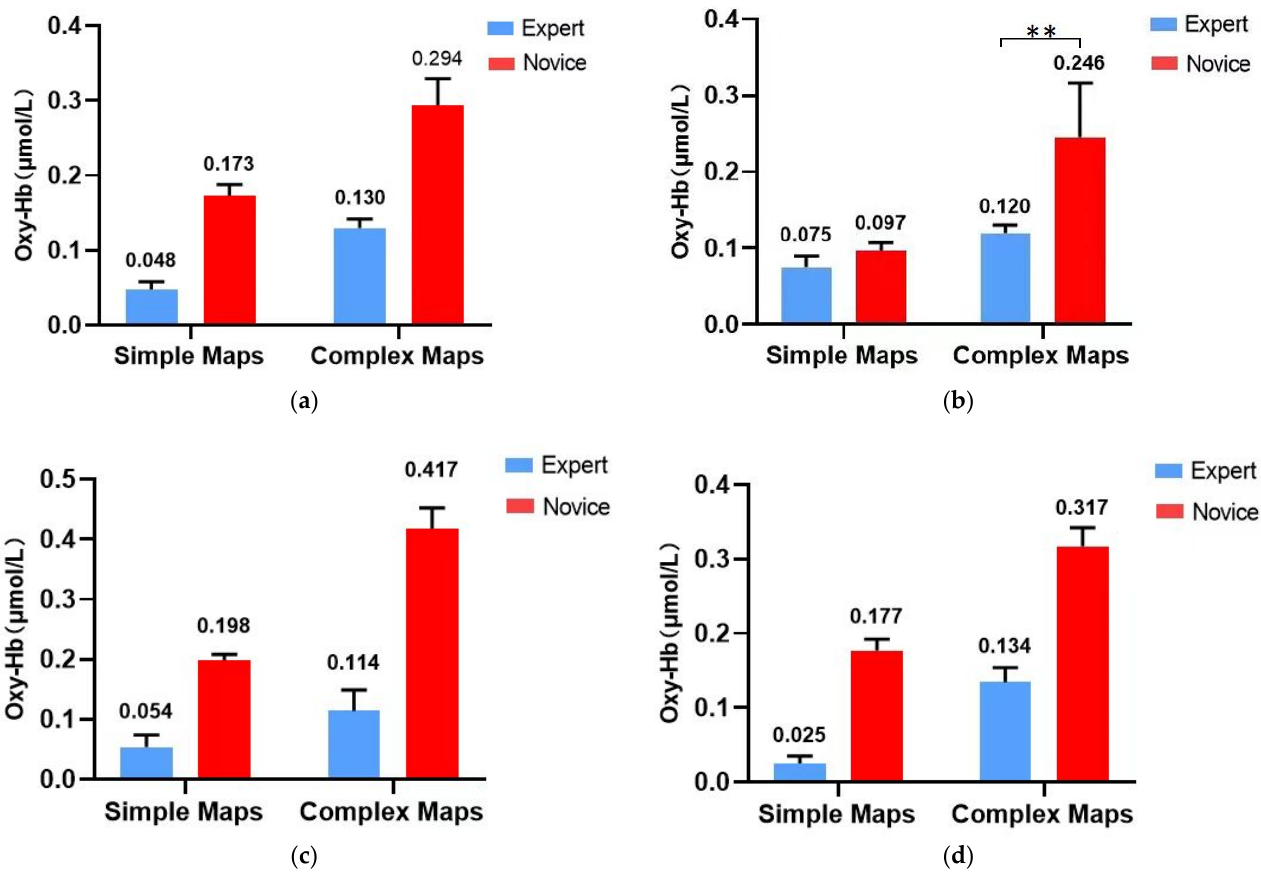
Table 5. Summary of oxygenated hemoglobin on ROI (M ± SD). Novice Group Expert Group